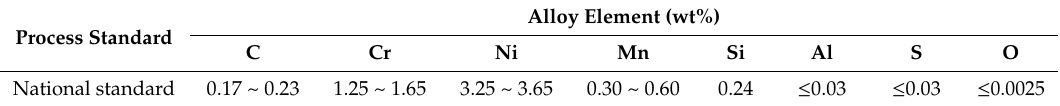
Table 1. 20Cr2Ni4 steel element content components.